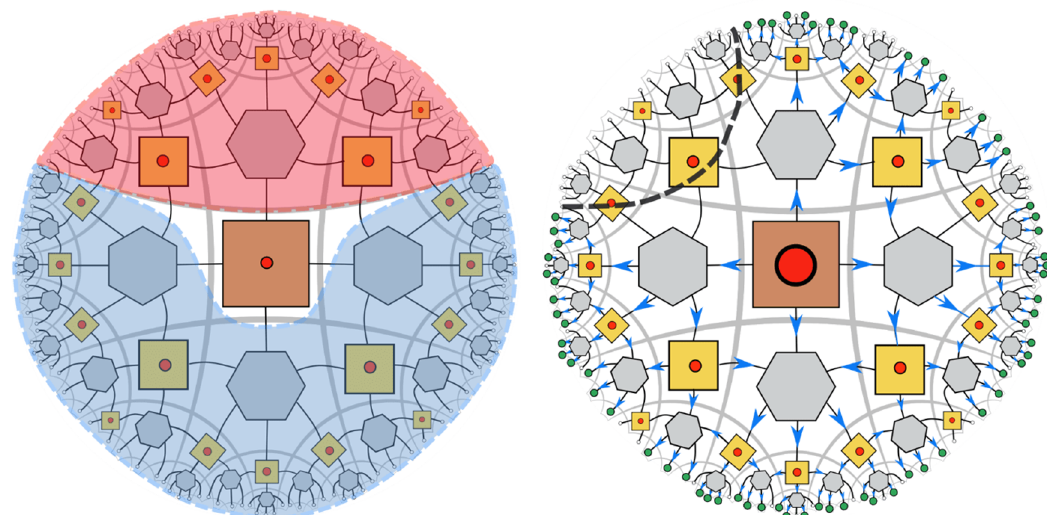
Figure 34. Left: when the central tile is approximate, its information cannot be recovered with perfect fidelity on either subregions. Greedy/entanglement wedges indicate where bulk information can be fully reconstructed. However, when the central qubit is in particular states, or equivalently, when the state of bottom wedge lives in a subspace C , then its information can be recovered on a i a subregion perfectly. Right: when we have enough support over the boundary, then the central qubit can be recovered